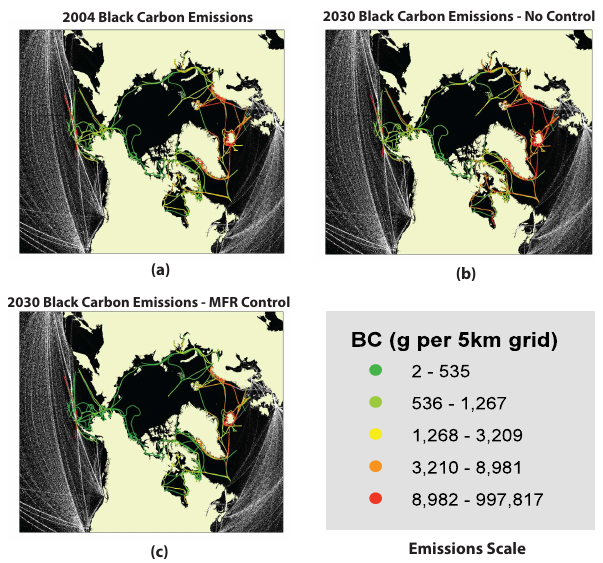
Fig. 2. Illustration of (a) 2004 black carbon emissions; (b) 2030 projections for black carbon; (c) 2030 black carbon with MFR con- trols.